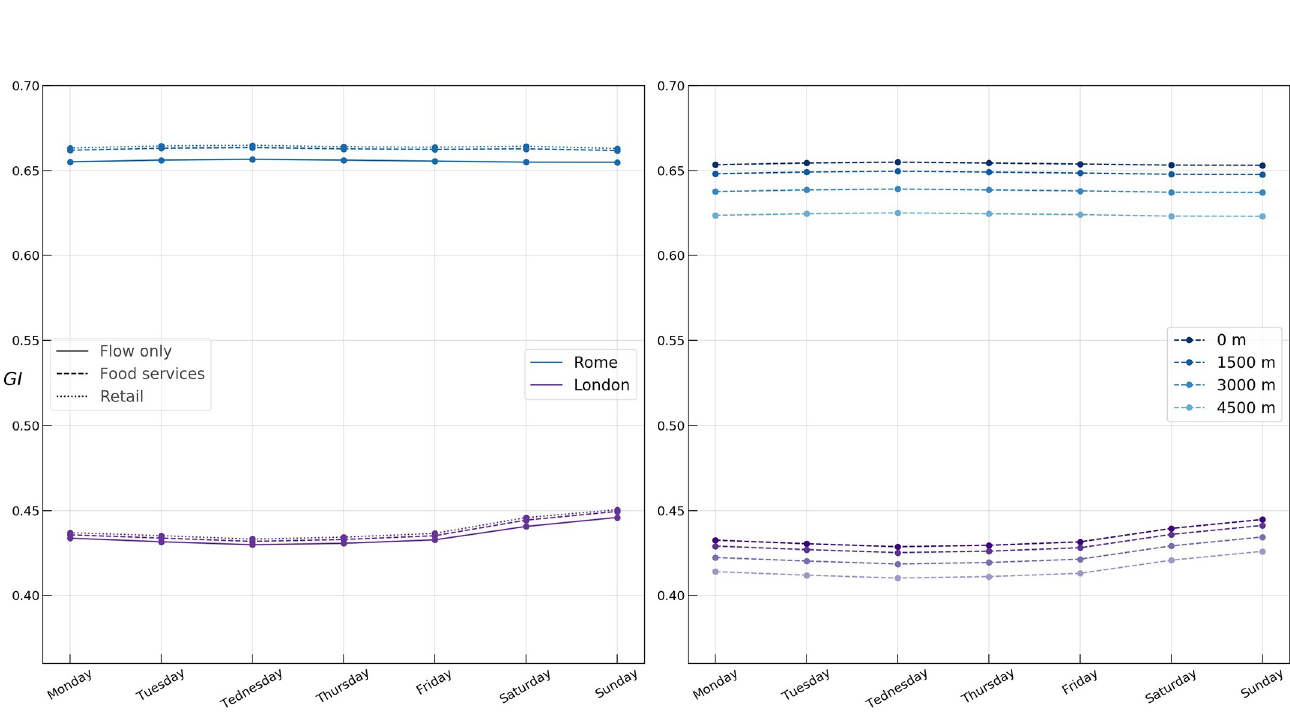
Fig 7. Gini (left) and Spatial Gini (right) coefficients during the week for flow only, food service, and retail activity in Rome and London.